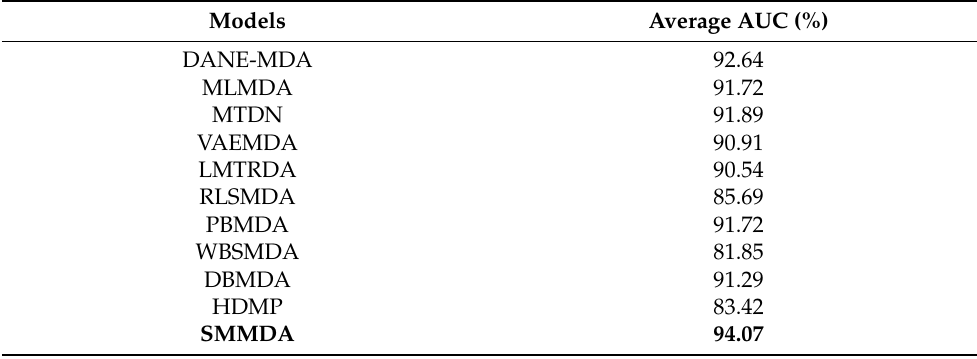
Table 4. Comparison of previous related works under the five-fold cross-validation.